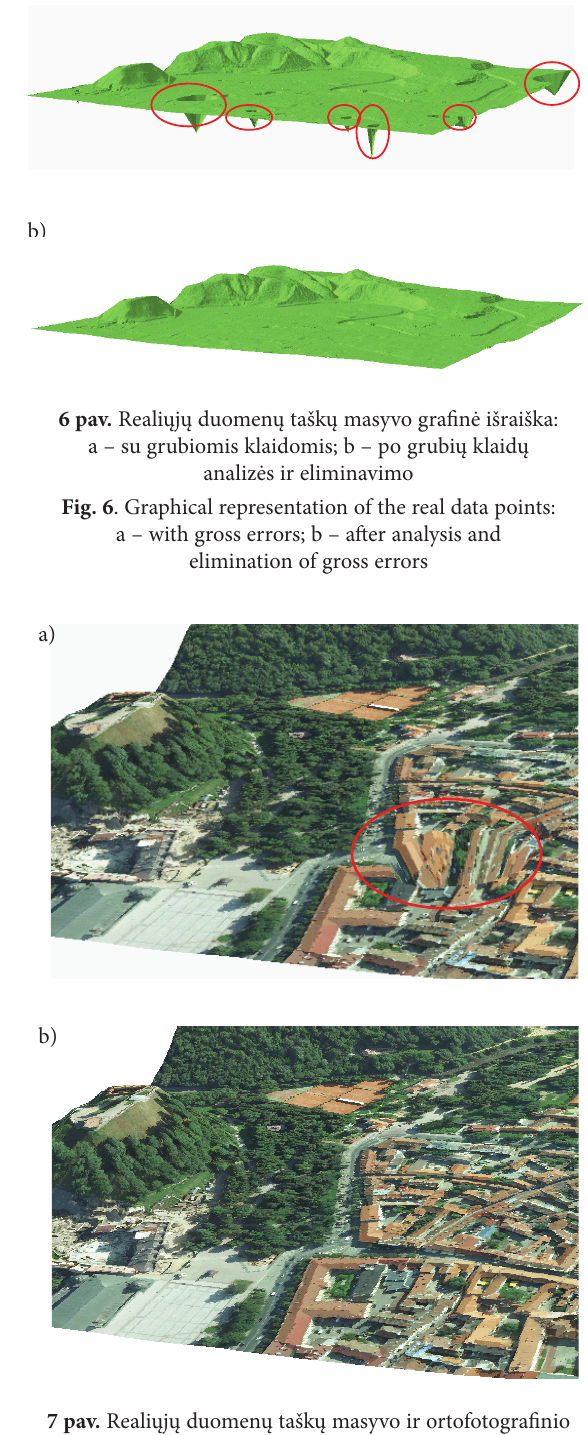
Fig. 7 . Example of the points cloud and orthophoto map graphical representation: a – with gross errors; b – after analysis and elimination of the gross errors 4. Išvados Analizuojant lazerinio skenavimo duomenų masyvus nustatyta, kad juose pasitaiko gamybos procese neelimi- nuotų grubių